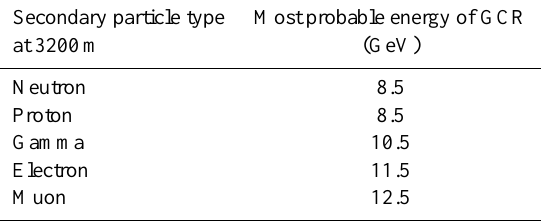
Table 4. The most probable energies of the Galactic protons cor- responding to the different types of secondary particles at 3200m above sea level.